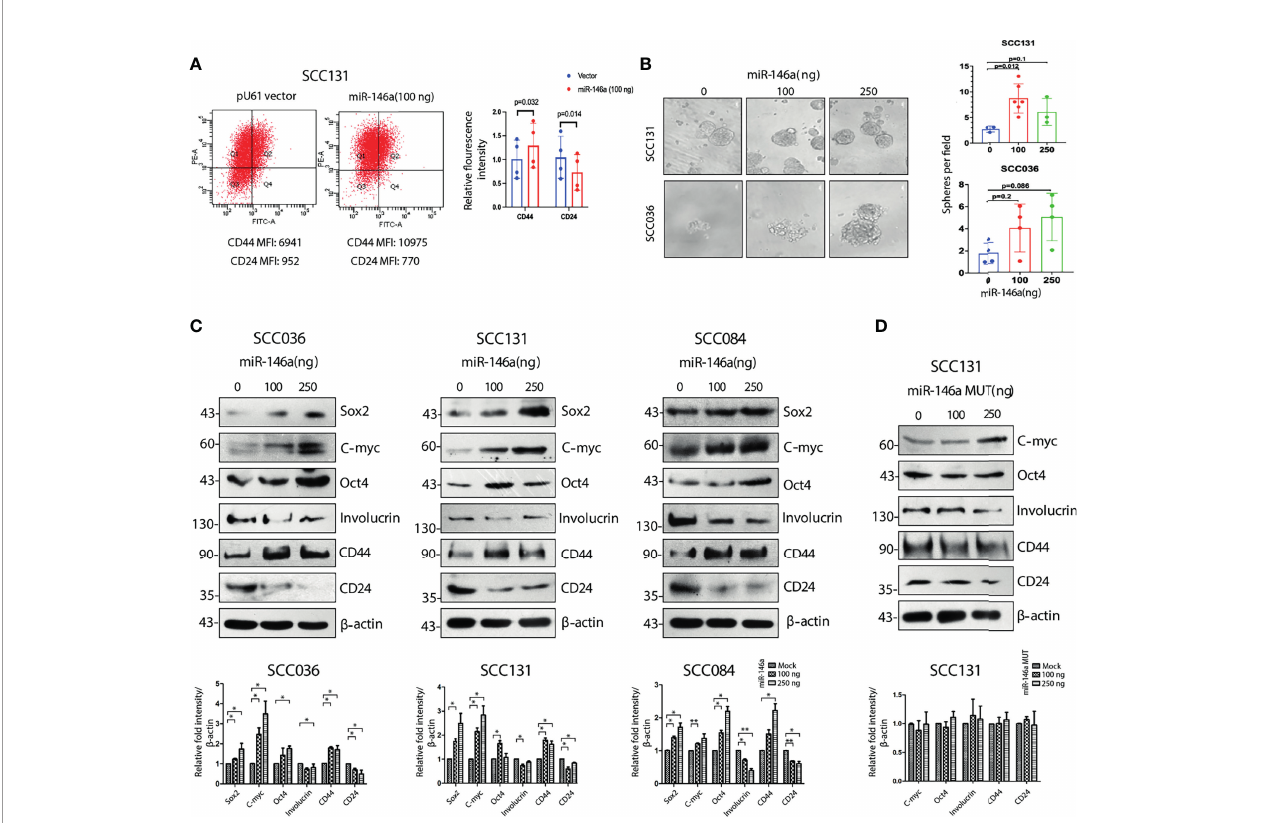
FIGURE 2 | Cancer stem cell characteristics induced by miR-146a in OSCC cell lines. (A) MiR-146a transfected SCC131 cells were analyzed by fl ow cytometry and fold change for the respective mean fl uorescence values of CD44 (PE) and CD24 (FITC) have been plotted (p values calculated using one sample t-test on logFC). (B) Equal number of vector and miR-146a transfected UPCI: SCC131 and UPCI: SCC036 cells were seeded in ultralow-attachment 6-well plate at clonal density. Sphere forming structures was captured at fi ve random fi elds at 20X magni fi cation using phase contrast microscope (Leica CTR4000) with scale bar equal to 50 µm. Number of spheres per fi eld were counted and plotted (p-value calculated by Mann whitney ’ s u test in GraphPad prism 8). (C) Representative images of western blots showing dose dependent increment of Sox2, C-myc, Oct-4, Involucrin and CD44, decrease in CD24 in the UPCI: SCC036, UPCI: SCC131 and UPCI: SCC084 upon ectopic expression of miR-146a. b -actin bands was used to normalize the data. Band intensities of each protein has been quanti fi ed from three biological replicates and the average ± sd is plotted in GraphPad prism 5 showing statistical signi fi cance in the respective graphs (below) (*P < 0.05, **P < 0.01) (D) Similar western blots upon transfection of miR-146a with mutated seed sequences in UPCI : SCC131 and its graphical representation